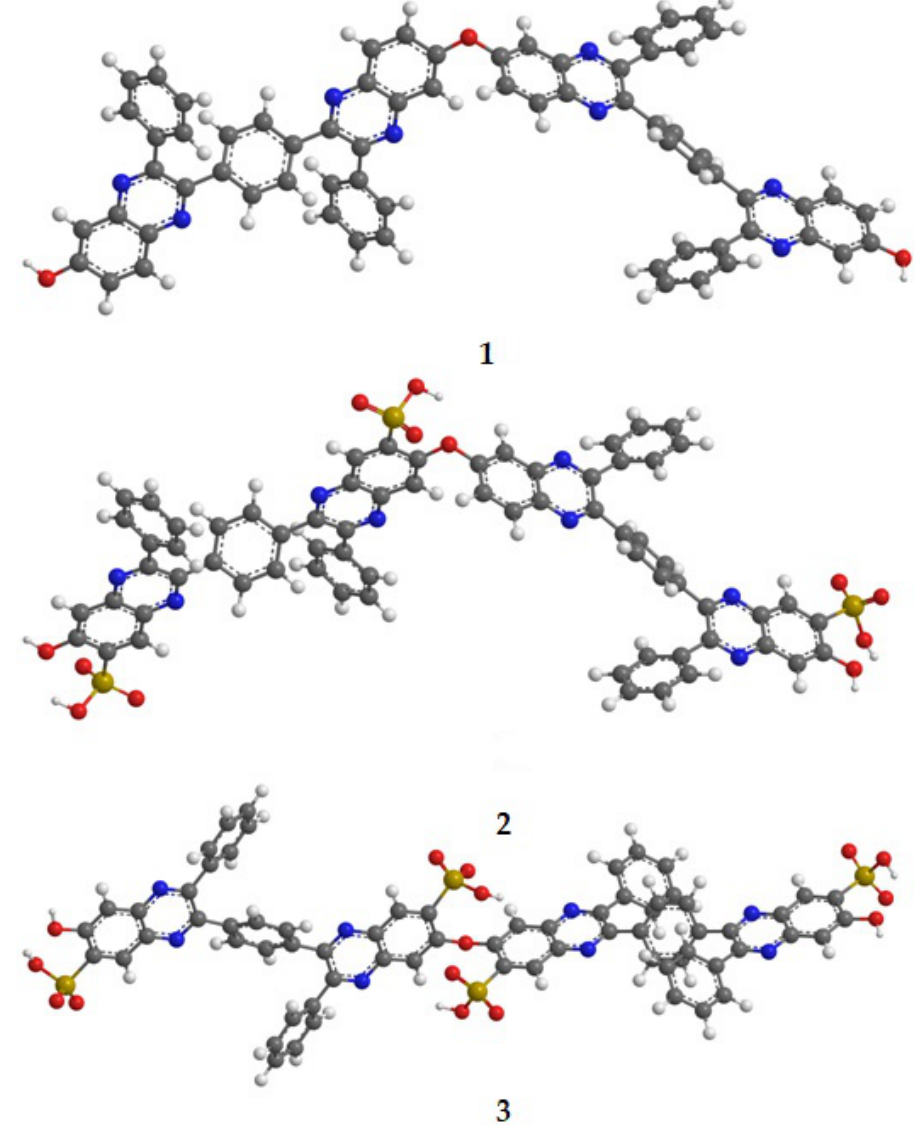
Figure 11. Double units of PPQ with one and two sulfogroups around the oxygen bridge.